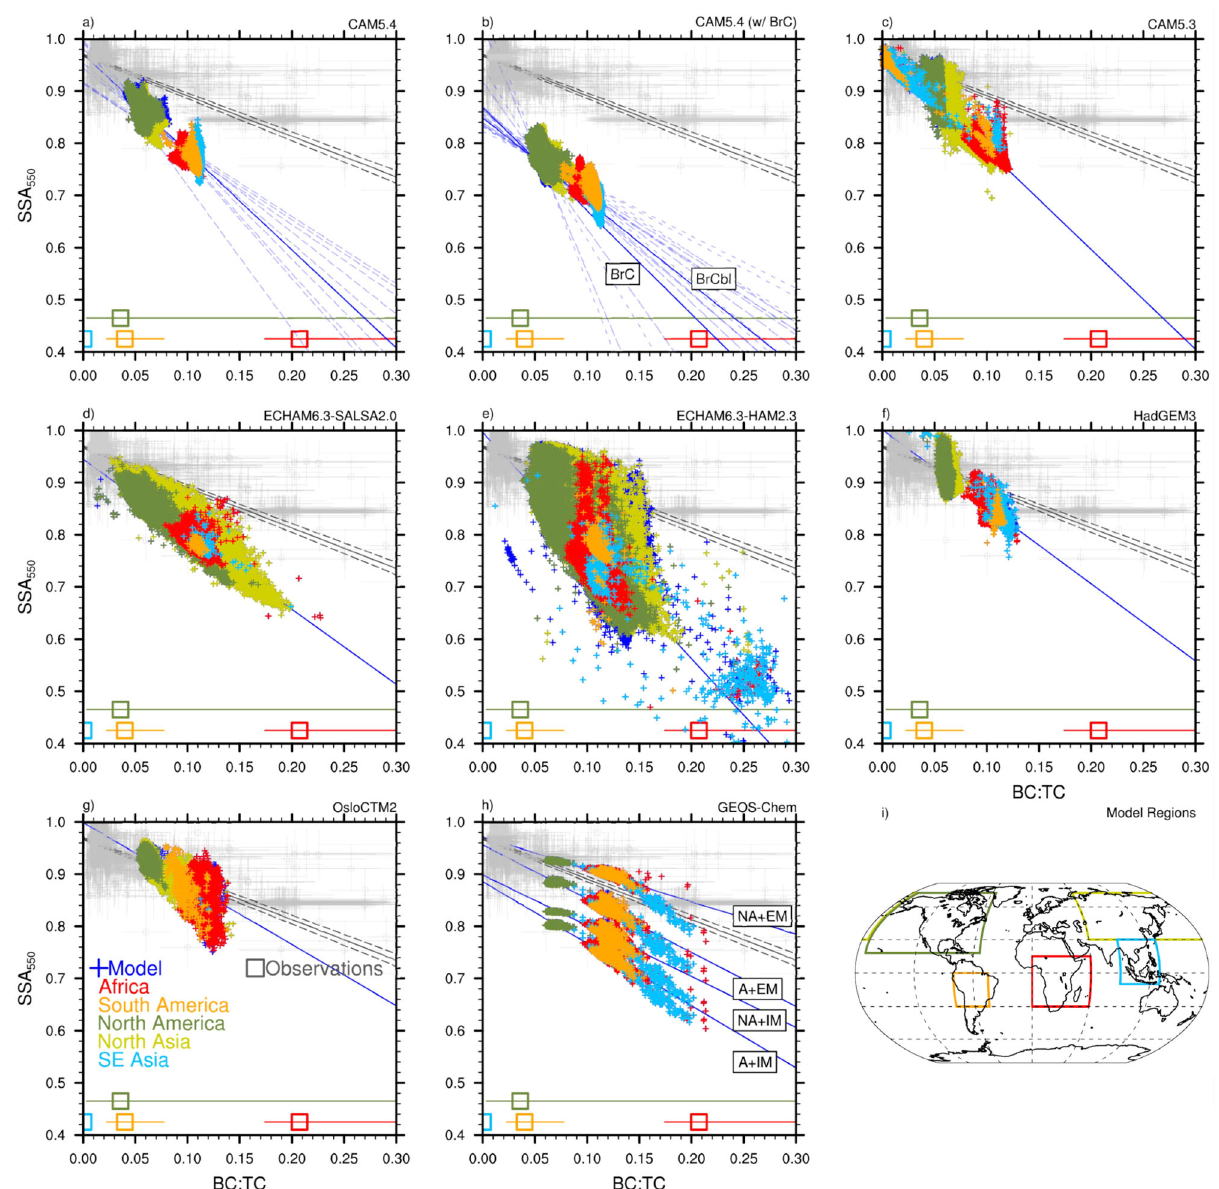
Fig. 2 Comparison of observed and modeled biomass burning single scattering albedo versus black carbon to total carbon ratio. All panels plot biomass burning (BB) single scattering albedo (SSA) at 550nm wavelength versus black carbon to total carbon ratio (BC:TC). Observational data is in gray. The model data is from a this study, b Brown et al. 17 , c – g AeroCom Phase-III simulations, and h Saleh et al. 16 . They are a CAM5.4, b CAM5.4 (w/ brown carbon (BrC)), c CAM5.3, d ECHAM6.3-SALSA2, e ECHAM6.3-HAM2.3, f HadGEM3, g OsloCTM2, and h GEOS-Chem. Model data is representative of BB in fl uenced regions which are color-coded in the model output and are speci fi ed on the global plot in i , de fi ned as Africa (red), South America (orange), North America (green), Northern Asia (yellow), and Southeastern Asia (light blue). Observational data from the speci fi c regions are averaged, and the regional average and range of the BC:TC observational data is included at the bottom of the plot (regionally color-coded squares). The two CAM5.4 simulations with BrC b represent brown carbon with and without photochemical bleaching (BrC and BrCbl, respectively). The four GEOS-Chem simulations h represent the four model simulations from Saleh et al. 16 : no BrC and externally mixed aerosols (NA + EM); BrC and externally mixed aerosols (A + EM); no BrC and internally mixed aerosols (NA + IM); and BrC and internally mixed aerosols (A + IM). Interannual variation in model slope and intercept is represented by dashed blue lines in a and b (in b , long dash = BrC, short dash = BrCbl). The solid gray line is the best fi t to observations, with dashed lines representing the 95% con fi dence intervals of the fi t. The best fi t to the model data is represented by the solid blue